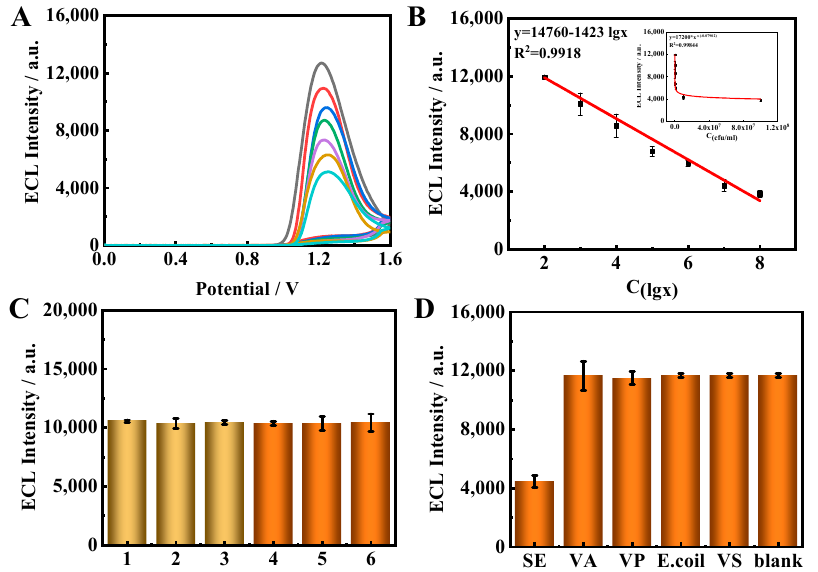
Figure 5. ( A ) ECL–time curves of the immunosensor towards different concentrations of targets: 1 × 10 2 , 1 × 10 3 , 1 × 10 4 , 1 × 10 5 , 1 × 10 6 , 1 × 10 7 and 1 × 10 8 CFU/mL. ( B ) Calibration curve of the sensor response to SE concentrations. ( C ) The stability of the proposed immune sensor to the target. ( D ) Selectivity of the proposed immunosensor for the target.